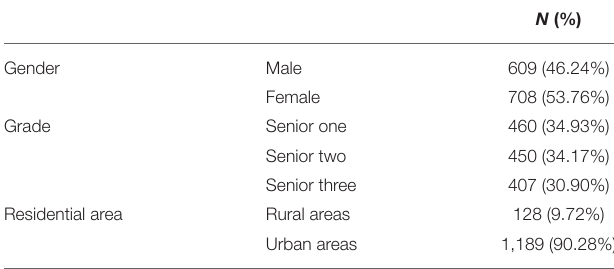
TABLE 1 | Sample background